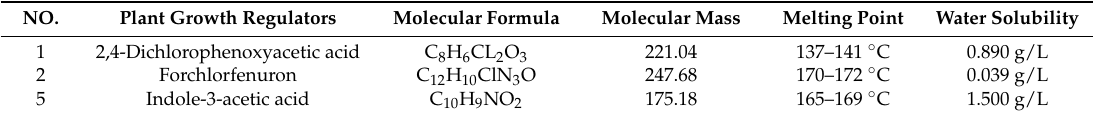
Table 1. Chemical and physicochemical properties of the